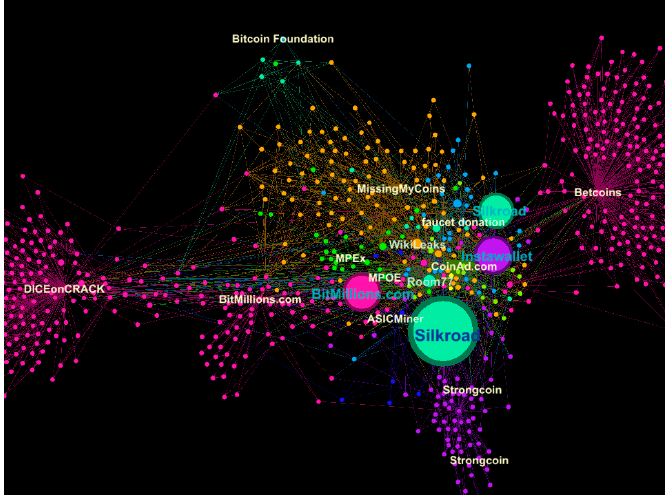
Figure 39. Visualization of Node Size (Number of Public Keys) in the Bitcoin Network.